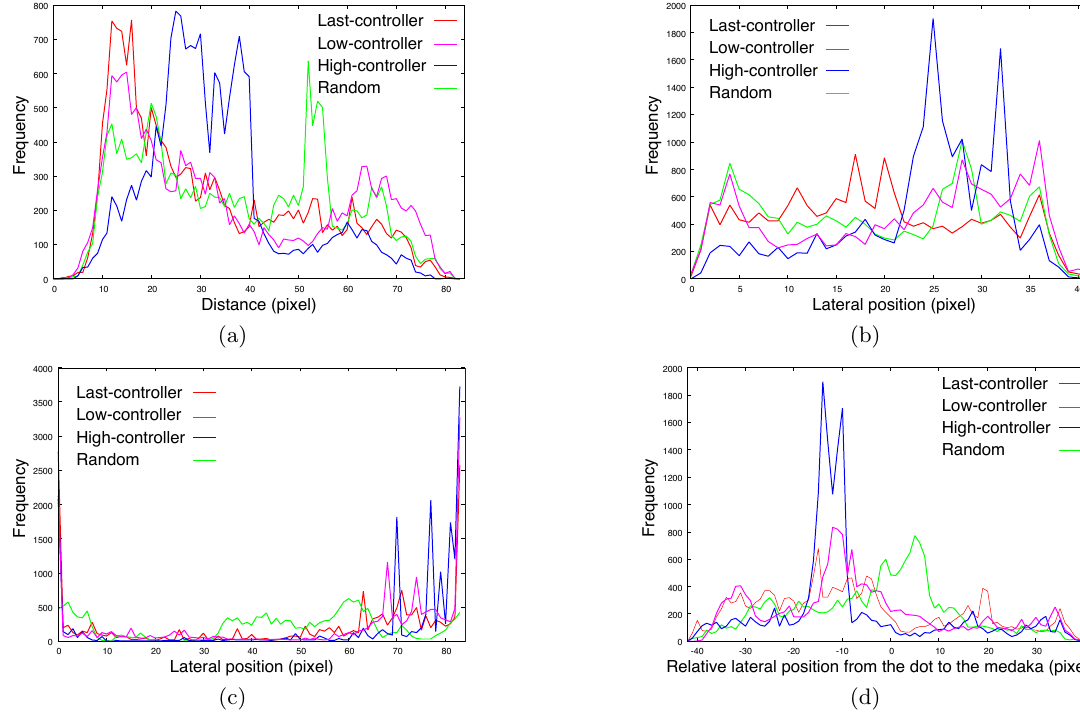
Figure 5: (a) distance from the medaka to the monitor. (b) lateral position of the medaka. (c) lateral position of the white dot. (d) relative lateral position from the white dot to the medaka.